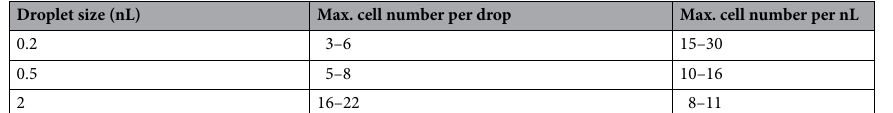
Droplet size (nL)